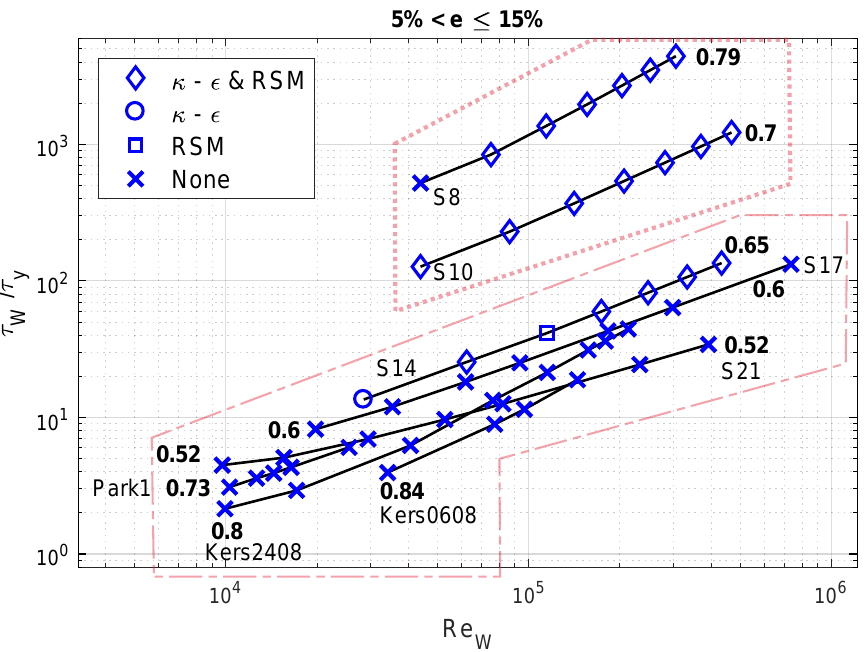
Figure 15. Performance of the standard RANS models to achieve an error 5% < e ≤